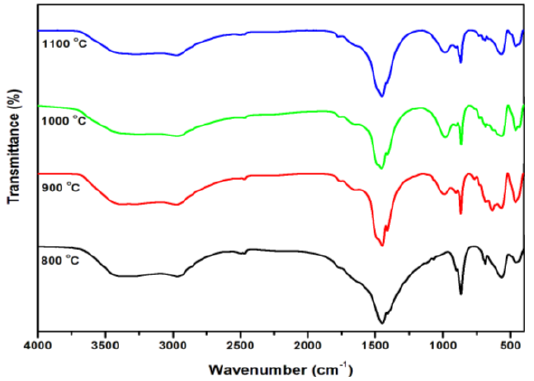
Figure 3. FTIR spectra of GdFeO 3 nanoparticles annealed at temperatures of 800 °C, 900 °C, 1000 °C, and 1100 °C. and 1100 ◦